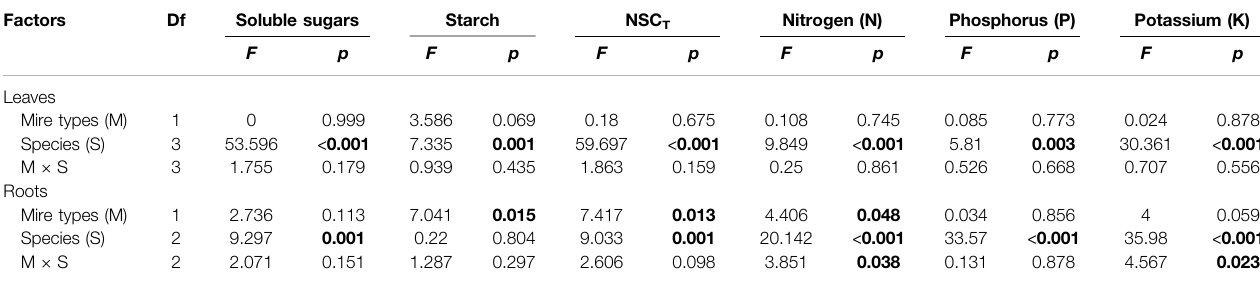
TABLE 3| Effects ofmire types, species, and their interactions onconcentrationsofNSCs (i.e.,sugars,starch,and NSC T ) and nutrients (i.e.,N, P,and K)inplant leaves and roots in September, tested with two-way nested ANOVAs. F and p values are given. Factors Df Soluble sugars Starch NSC T Nitrogen